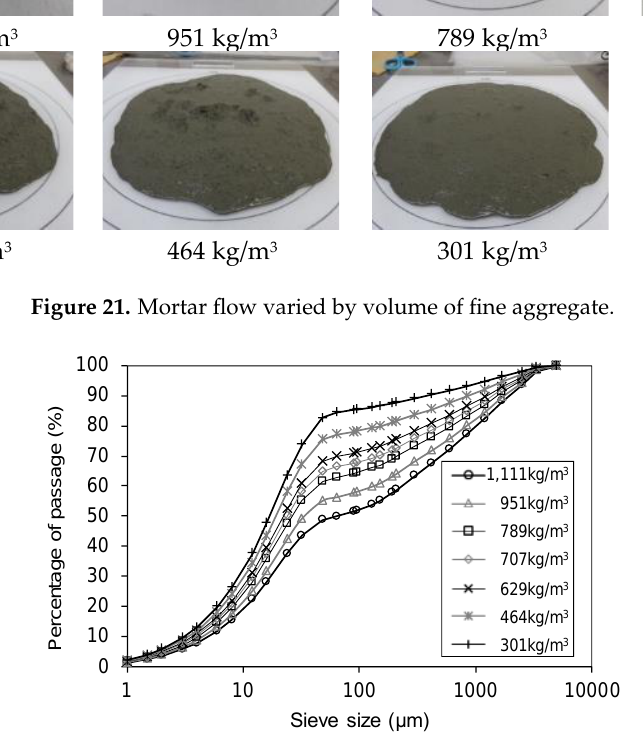
Figure 23. Compressive strength of UHPFRC with various volume of fine aggregate.